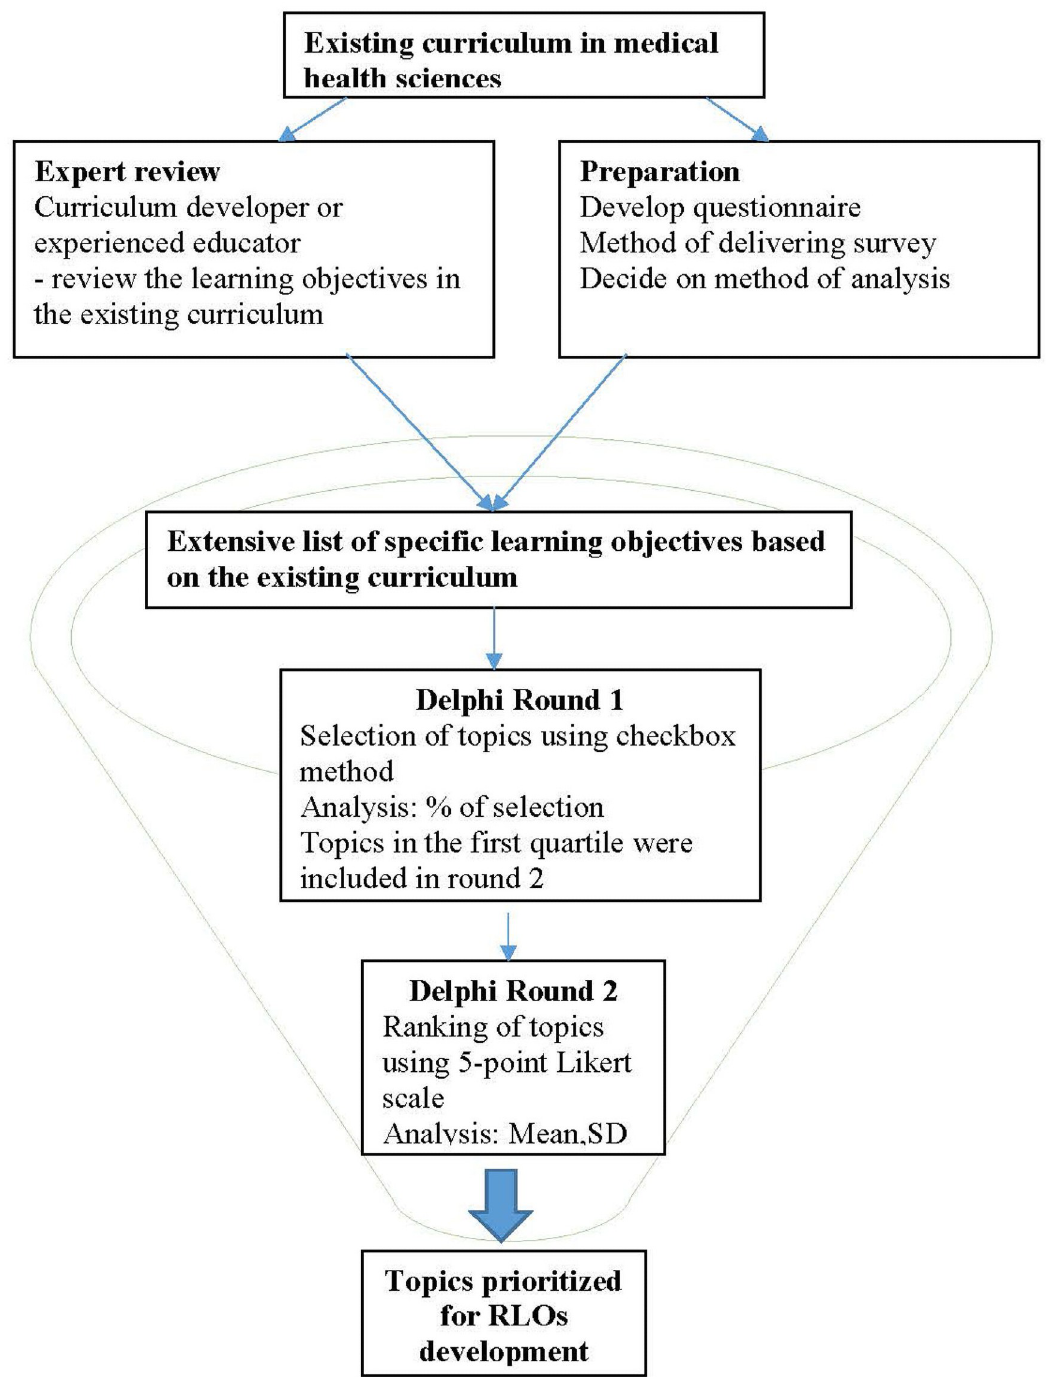
Fig 1. Flowchart of the modified Delphi survey in prioritising topics for reusable learning object (RLO) development, a funnel decision-making model.